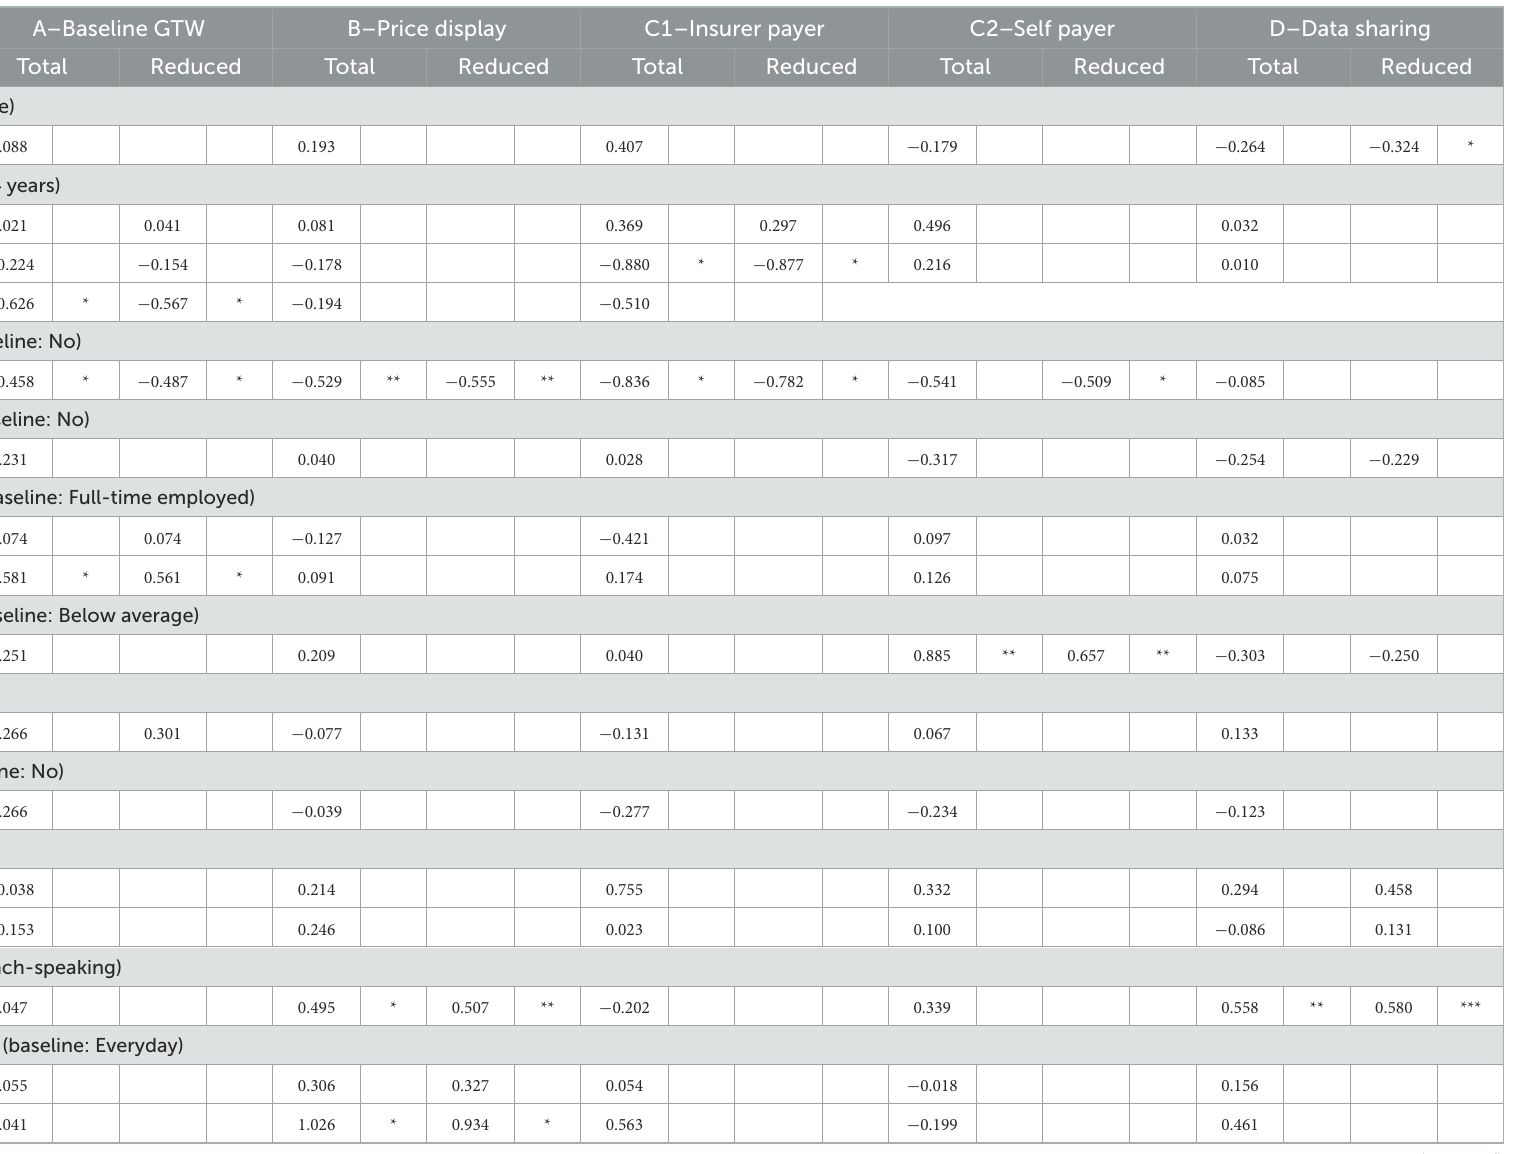
TABLE 12 Regression results for the overall and reduced models.